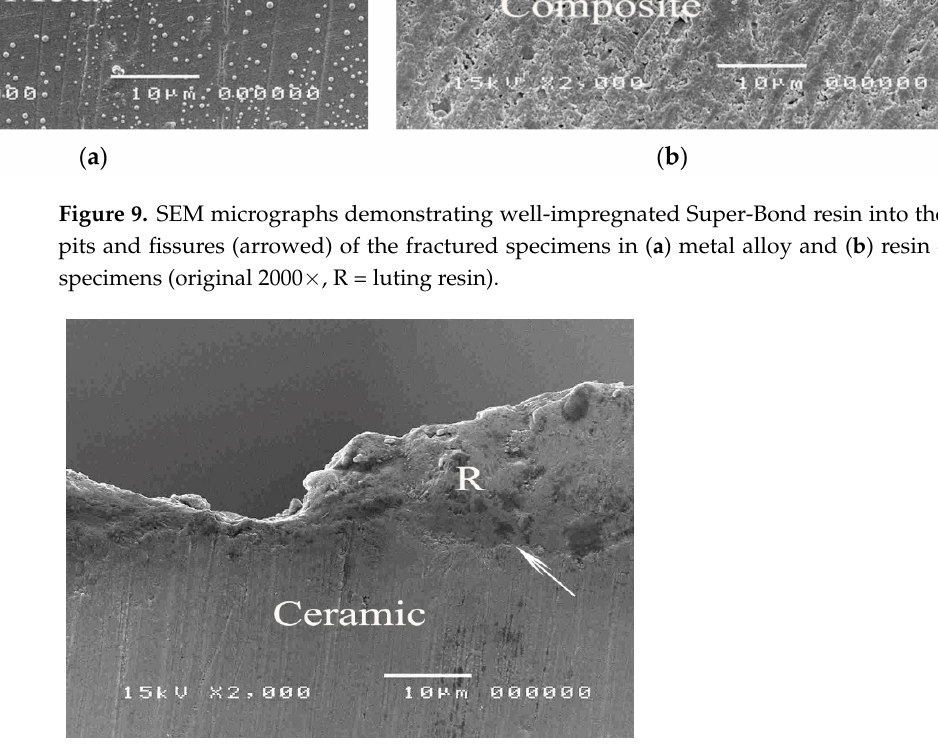
Figure 10. An SEM micrograph of the resin-ceramic interface using Super-Bond demonstrating the shallow irregularity on the ceramic surface of the fractured specimen (original ×2000, R = luting resin).